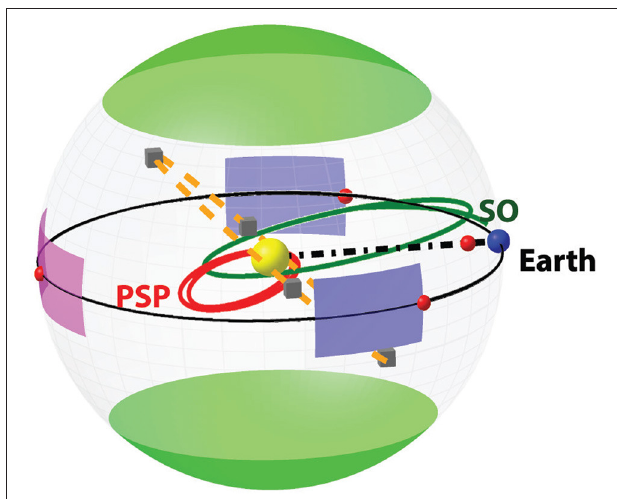
FIGURE 8 | Interesting viewpoints shown as in Figure 1 , with Parker Solar Probe (PSP; red) and Solar Orbiter (SO; green) orbits overlaid. The dashed orange line represents a sample “diamond” orbit with four spacecraft (gray cubes) 90 ◦ apart, reaching as high as 75 ◦ heliolatitude (Vourlidas, 2017). The colored patches on the 1AU sphere are the same as in Figure 1